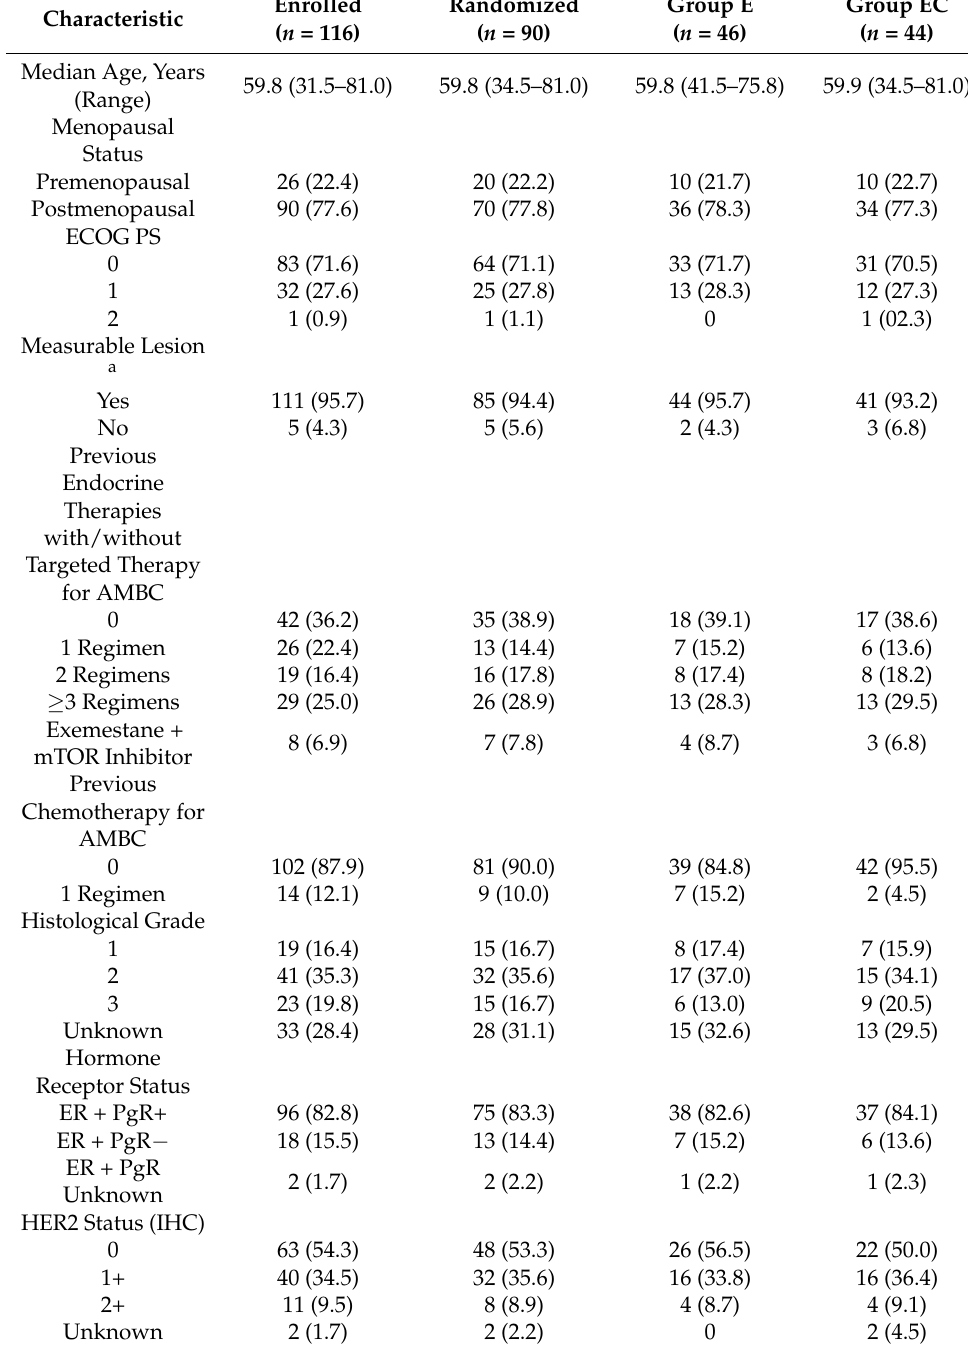
Table 1. Baseline